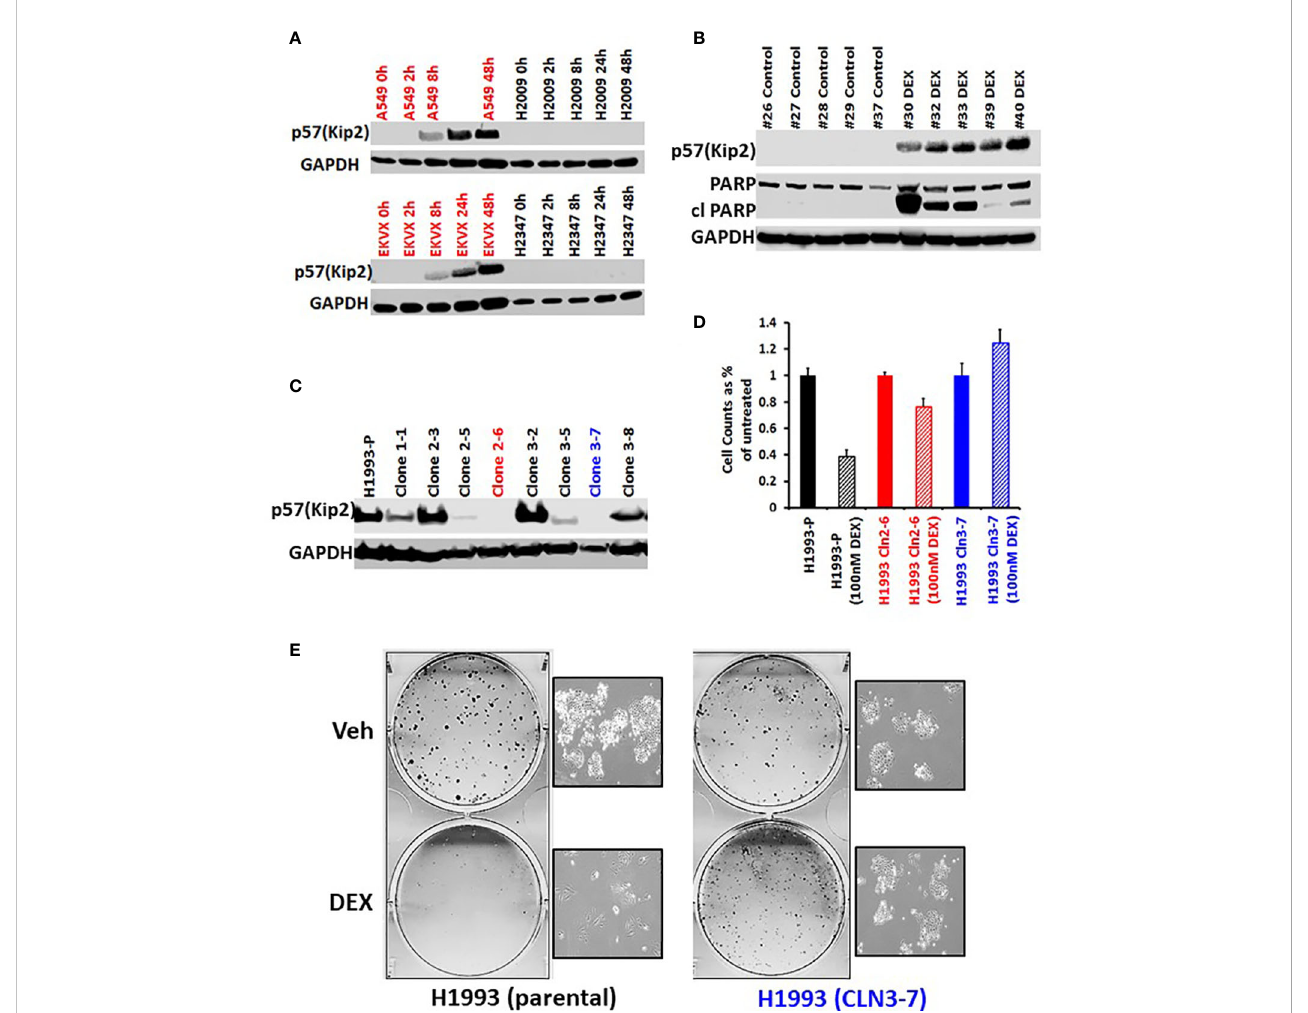
FIGURE 6 GR mediated up-regulation of p57(Kip2) expression is responsible for the cell cycle arrest in DEX-sensitive cells. (A) Western blot showing time course of p57(Kip2) protein appearance after DEX treatment in sensitive (A549, EKVX) and resistant (NCI-H2009, NCI-H2347) cells. (B) Western blot of LKB1 mutant PDX tumor exhibiting p57(Kip2) expression and the appearance of cleaved PARP in the DEX treatment group. (C) Western blot of NCI-H1993 CRISPR clones and parental (H1993-P) after DEX treatment (100nM, 24 hrs.). NCI-H1993 CRISPr clones 2-6 (red) and 3-7 (blue) show no p57(Kip2) after DEX treatment and were used in subsequent cell proliferation assays. (D) Cell counts after DEX treatment with parental NCI-H1993 and CRISPR knockout clones NCI-H1993 cln2-6 and cln3-7. (E) Colony formation assay con fi rming loss of cell cycle arrest after CRISPR knockout of CDKN1C gene in DEX- sensitive NCI-H1993. Inset shows exemplar bright fi eld images of colonies from the colony formation assay plates